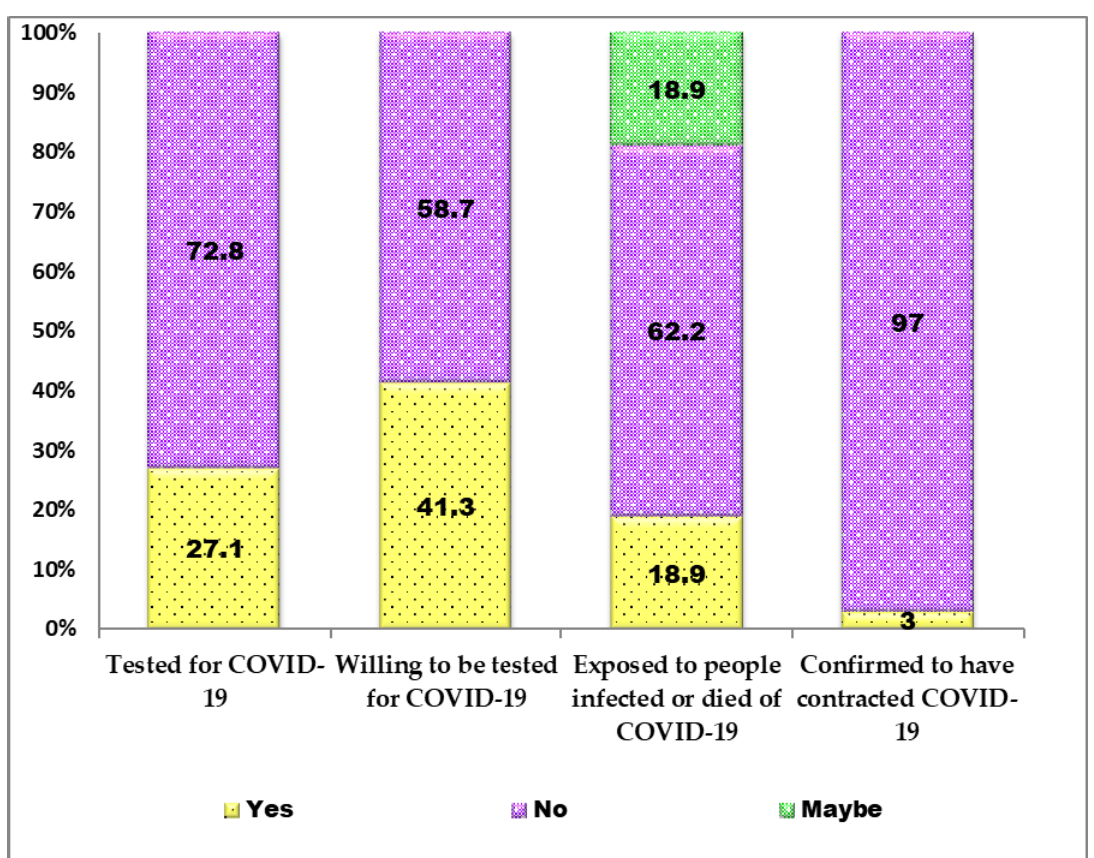
Figure 5. SARS-CoV-2 testing and infection status of Nigerian healthcare workers, academics and tertiary students ( n = 1525) surveyed for COVID-19 vaccine acceptance and hesitancy.